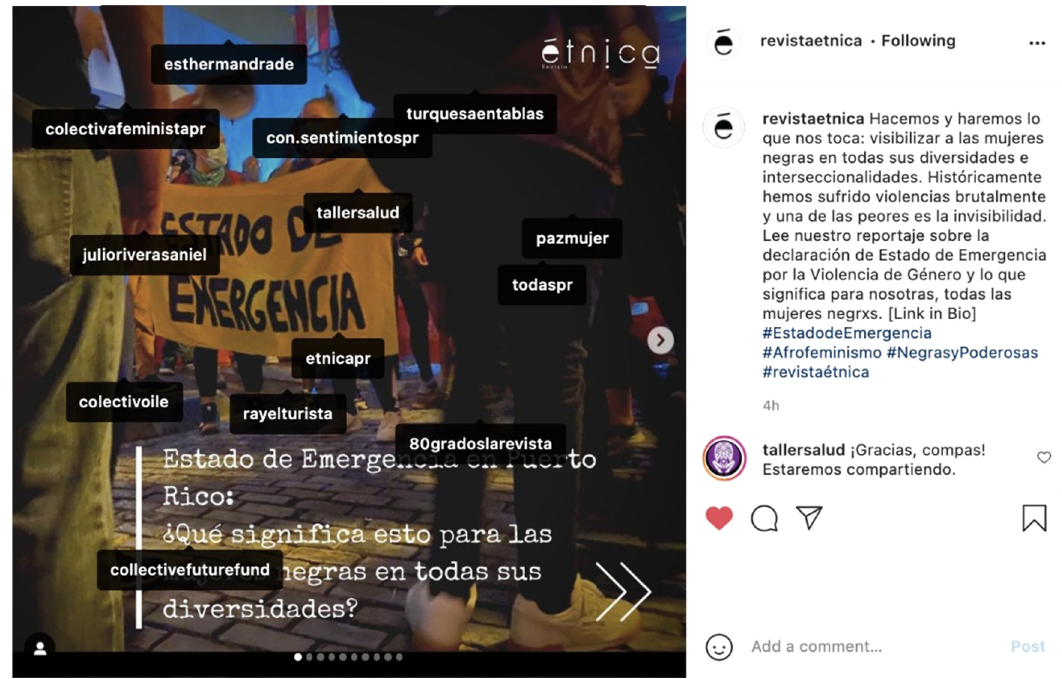
Figure 1: Screenshot from Revista Étnica Instagram Page.